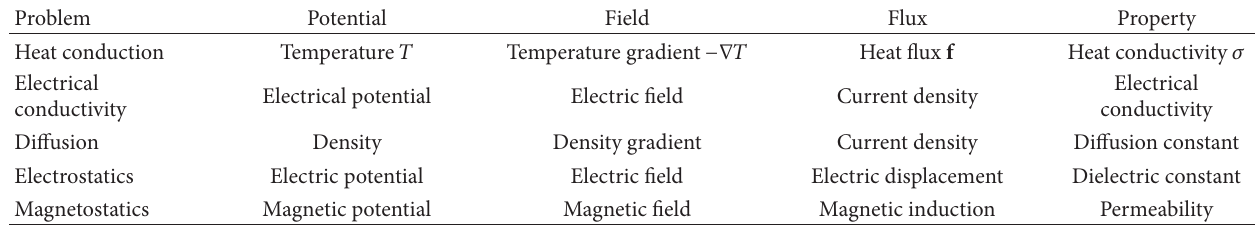
Table 1: Mathematically equivalent properties (according to